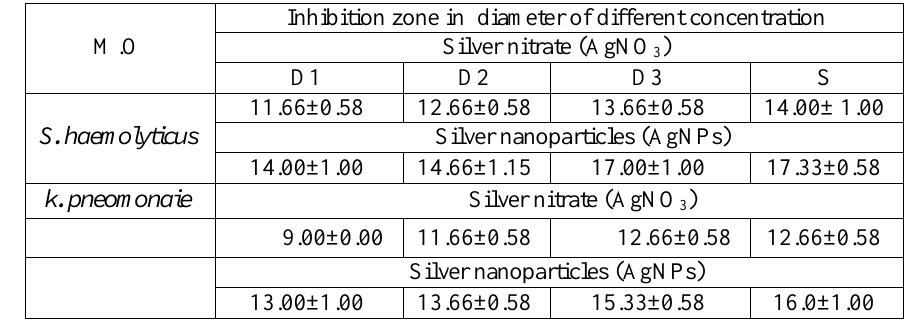
Table 2. Antibacterial activity of AgNPs and biosynthesized AgNPs against two types of pathogenic bacteria.